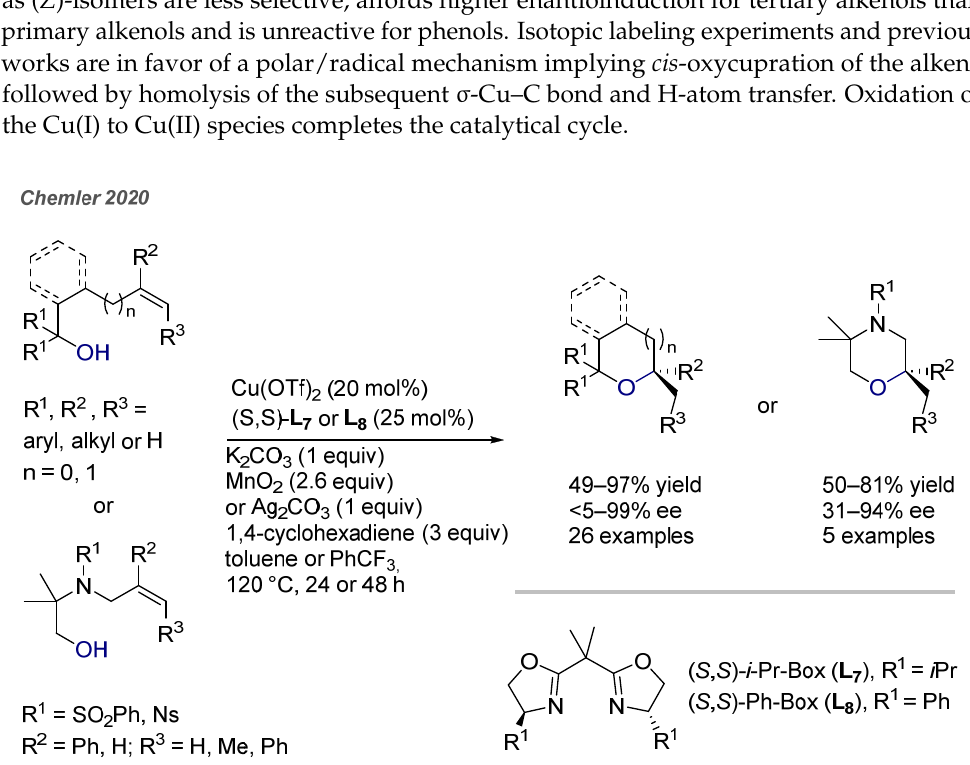
Figure 22. Cu(II)-bis(oxazoline)-catalyzed enantioselective cyclohydroalkoxylation of 4- and 5- alkenols. ee = enantiomeric excess.